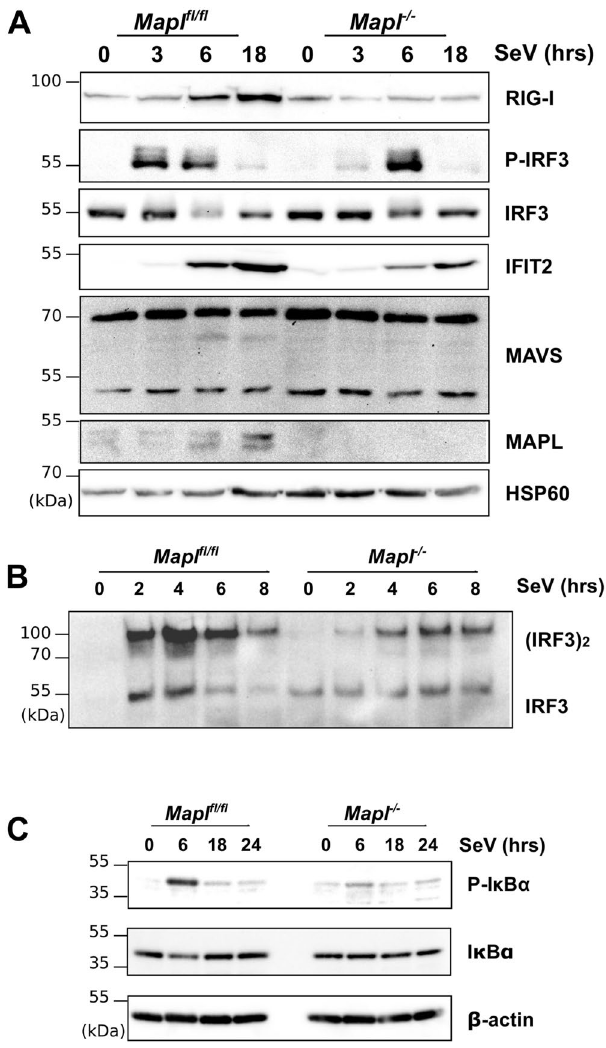
Figure 3. MAPL is required for early steps of immune response to Sendai virus infection. ( A ) Mapl fl/fl and Mapl − / − MEFs were left untreated or infected with Sendai virus (150 HAU/mL) for up to 18 hours and lysates were immunoblotted. ( B ) IRF3 dimerization assay. Cells were infected with Sendai virus (150 HAU/mL) for the indicated periods, lysed, ran on a native gel and immunoblotted. ( C ) Nf- κ B activation. Cells were left untreated or infected with Sendai virus (150 HAU/mL) for up to 24 hours and lysates were